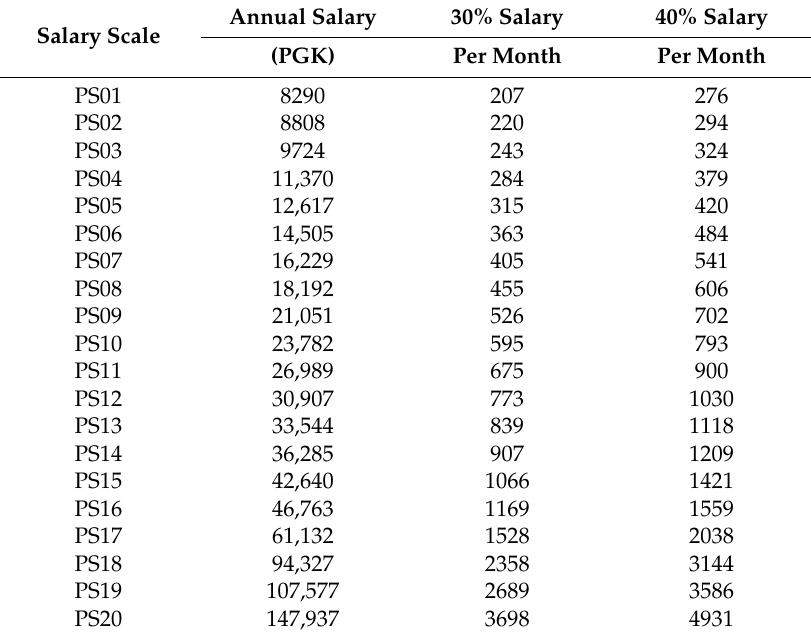
Table 2. Salary scale in relation to annual salary for public service